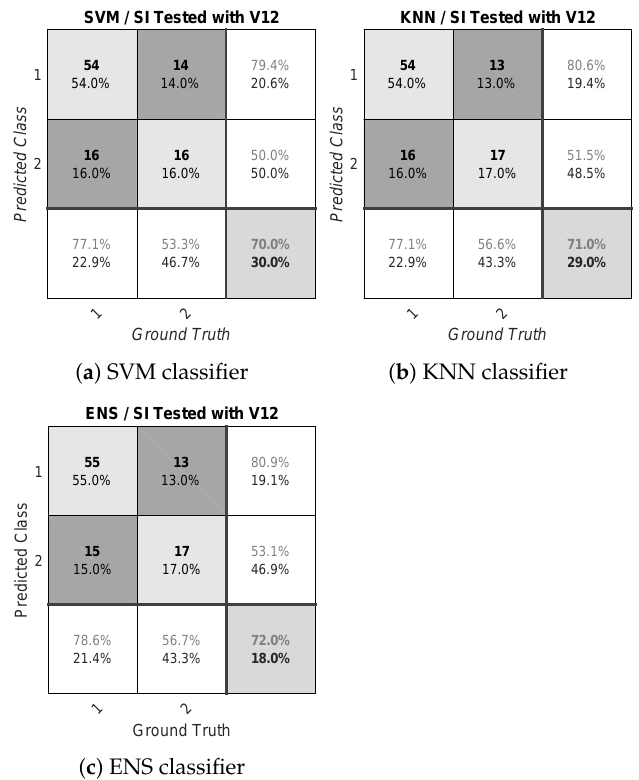
Figure A22. Confusion matrices for a subject-independent model tested with